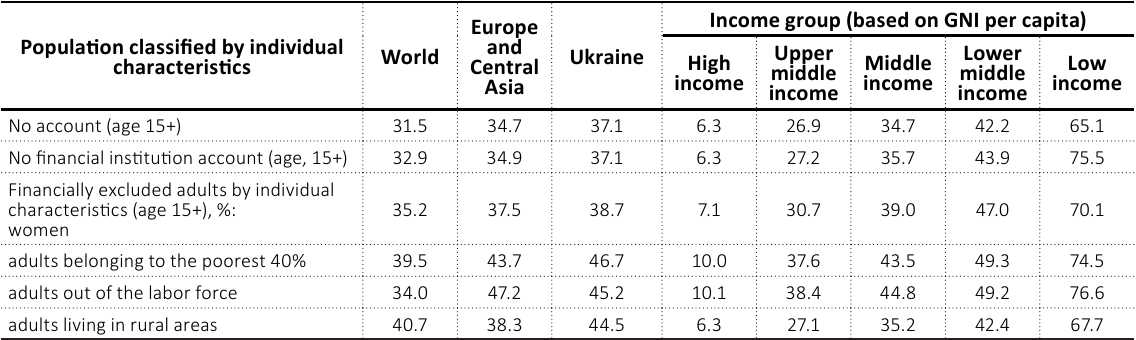
Table 1. Financially excluded population in Ukraine and other countries, 2017, % Population classified by individual characteristics World